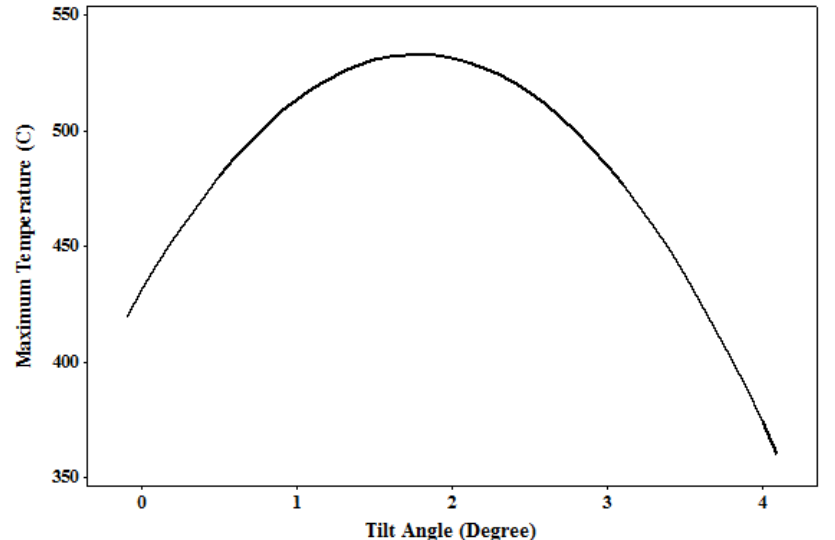
Figure 9. Maximum temperature vs. tilt angle for welded samples.